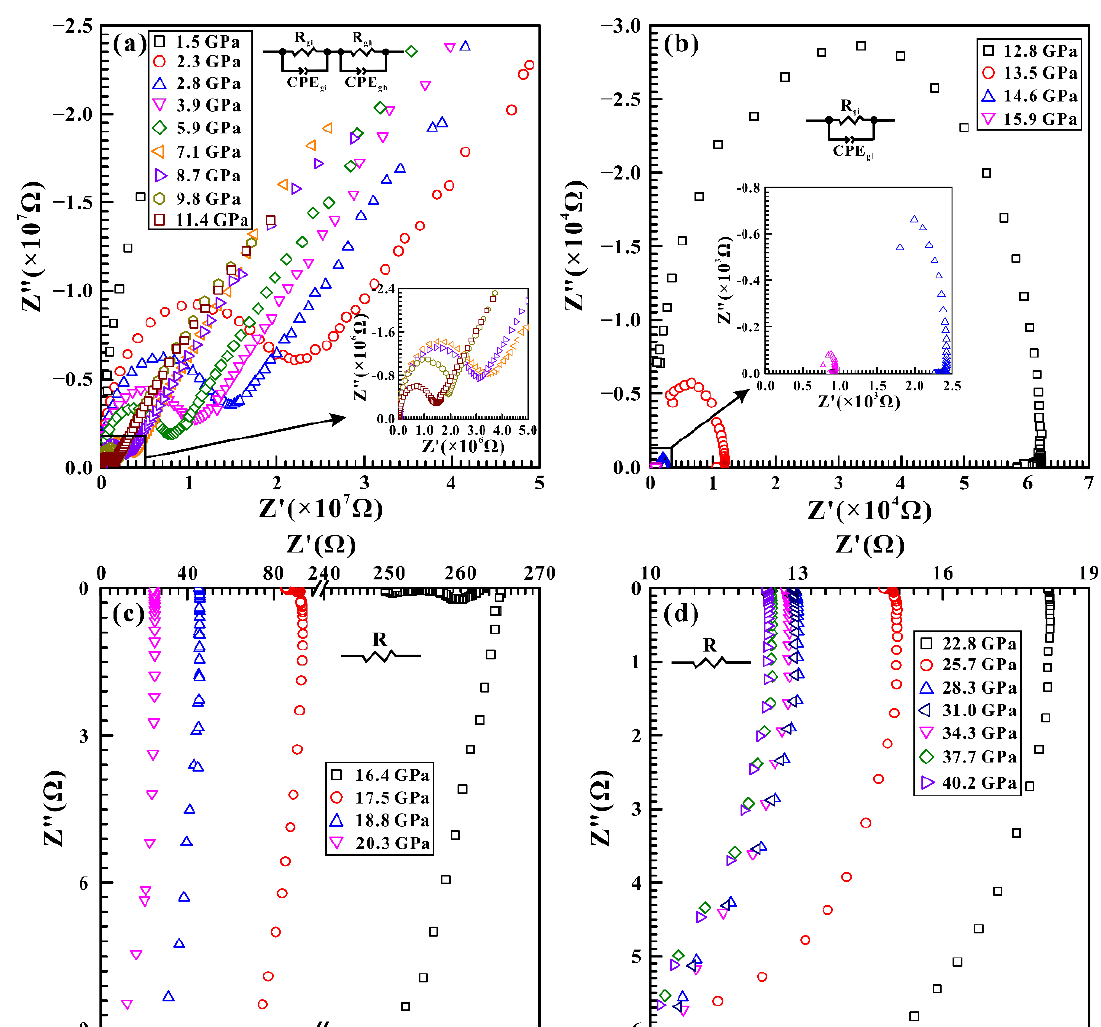
Figure 5. Complex impedance spectra of Ga 2 Se 3 measured under the conditions of room temperature and ( a ) 1.5–11.4 GPa; ( b ) 12.8–15.9 GPa; ( c ) 16.4–20.3 GPa; and ( d ) 22.8–40.2 GPa, respectively. Z’ and Z" are the real and imaginary parts of the complex impedance, respectively. An appropriate equivalent circuit of a single R/CPE in parallel is employed to fit the high-frequency semicircle arc and the low-frequency tail. Here, R gi and R gb are the resistances of the grain interior and grain boundary, respectively. CPE gi and CPE gb stand for the constant phase elements of the grain interior and grain boundary, respectively. The impedance spectra appearing in the fourth quadrant can be modeled by the simple resistance (R).